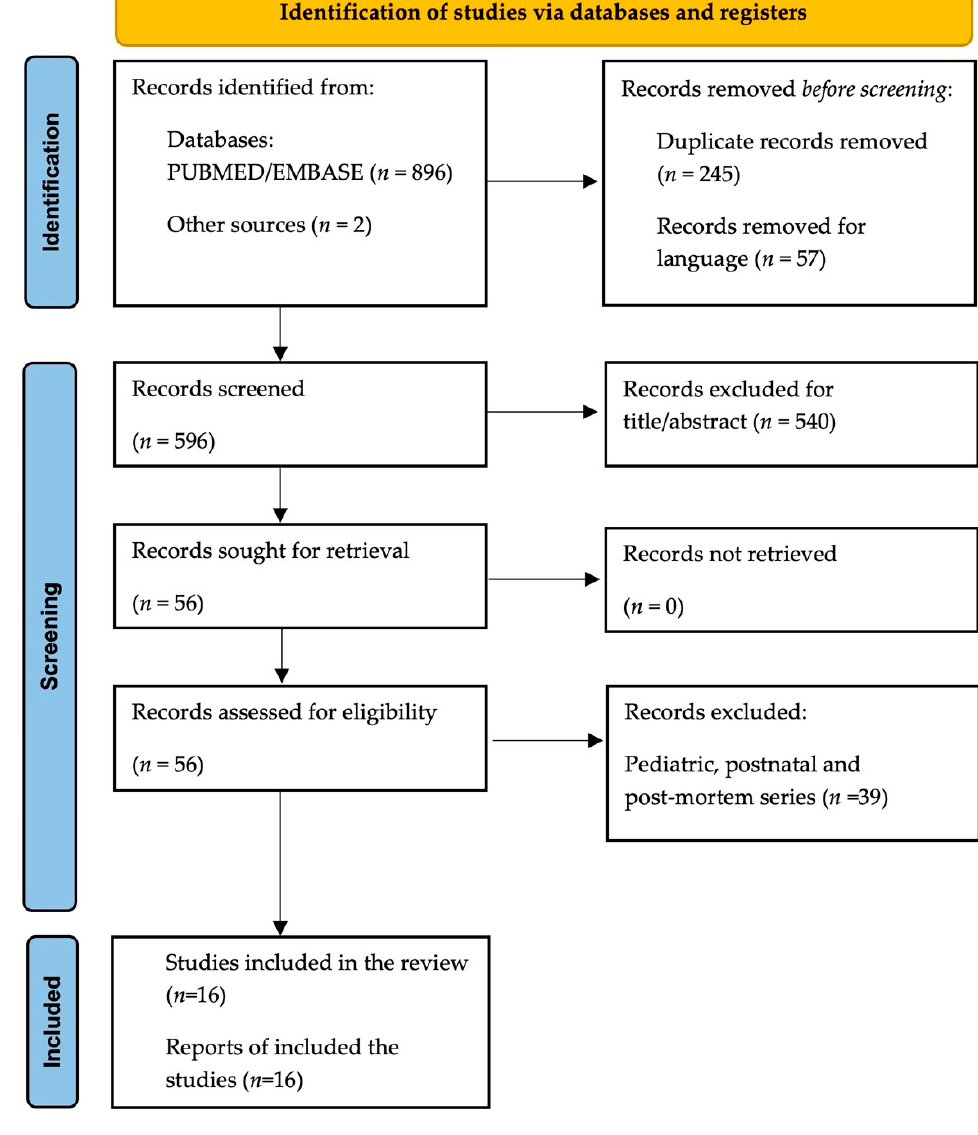
Figure 1. PRISMA flowchart of study selection.